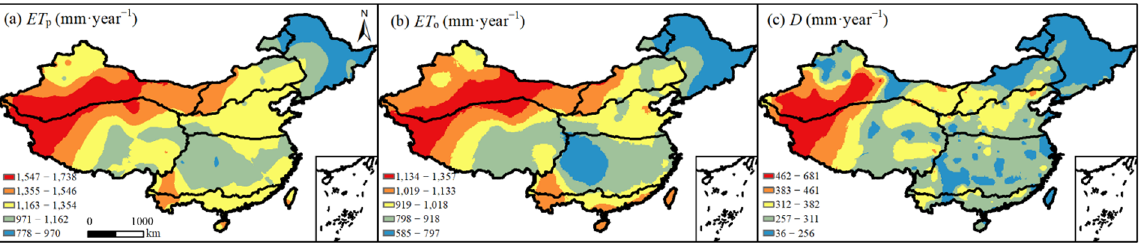
Figure 8. The spatial distribution of longterm mean annual ( a ) ET p , ( b ) ET o , and ( c ) D in mainland China.